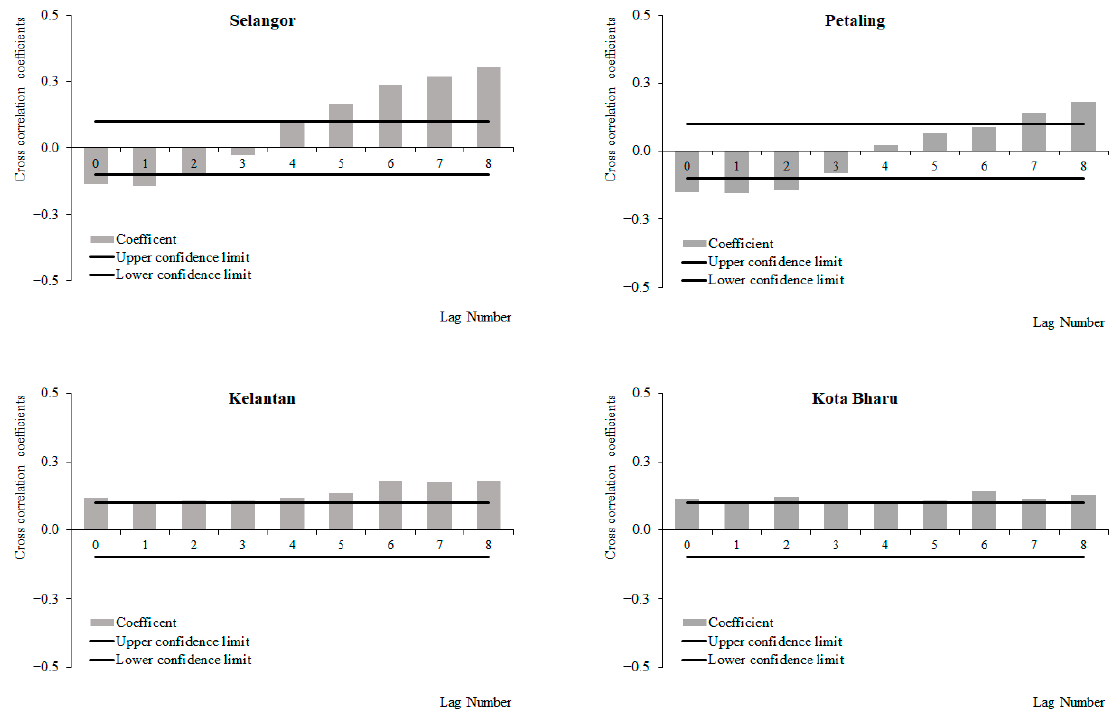
Figure 7. Cross-correlation function between dengue cases and rainfall in Selangor, Petaling, Kelantan and Kota Baharu, 2015 to 2019.